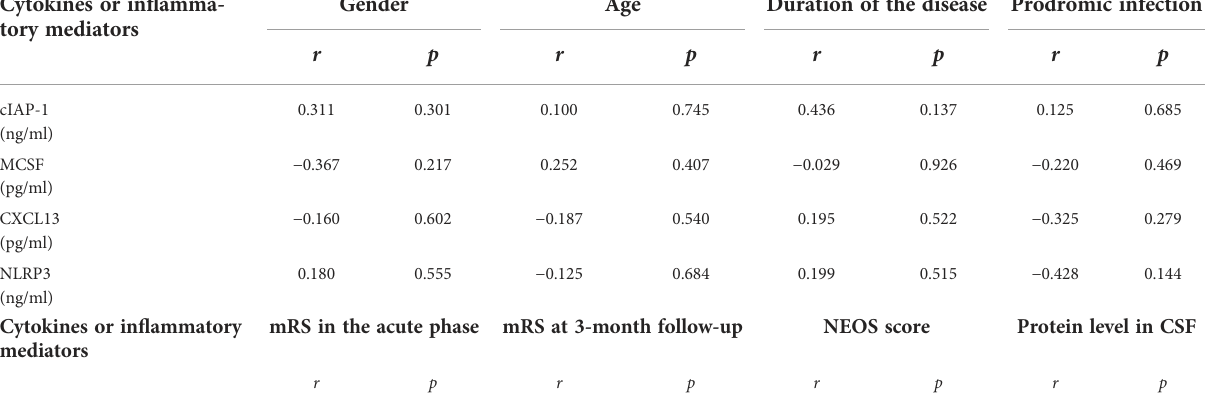
TABLE 4 CSF cytokines and in fl ammatory mediator levels correlated with clinical features of anti-NMDAR encephalitis patients. Cytokines or in fl